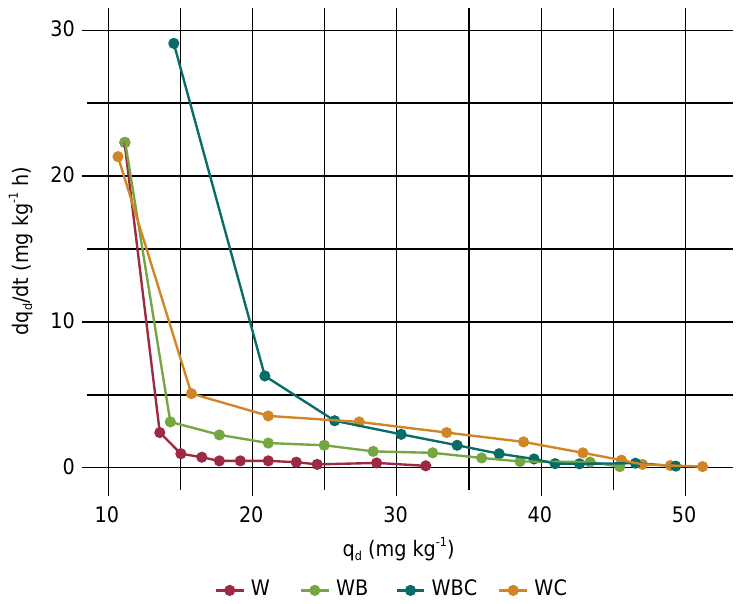
Figure 5. Phosphorus desorption rates in Fe mining waste (W) enriched with organic compost (WC), biochar (WB), and a combination of both amendments (WBC).